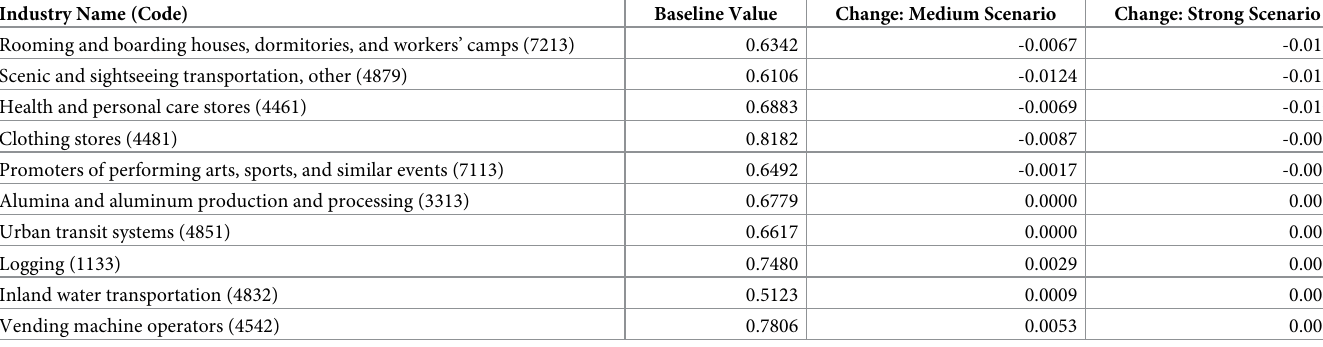
Table 11. Projected change in fraction of jobs susceptible to automation by 4-digit